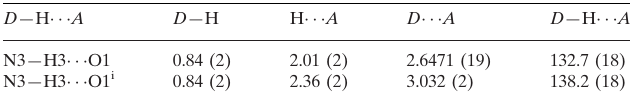
Data collection: CrystalClear (Molecular Structure Corporation